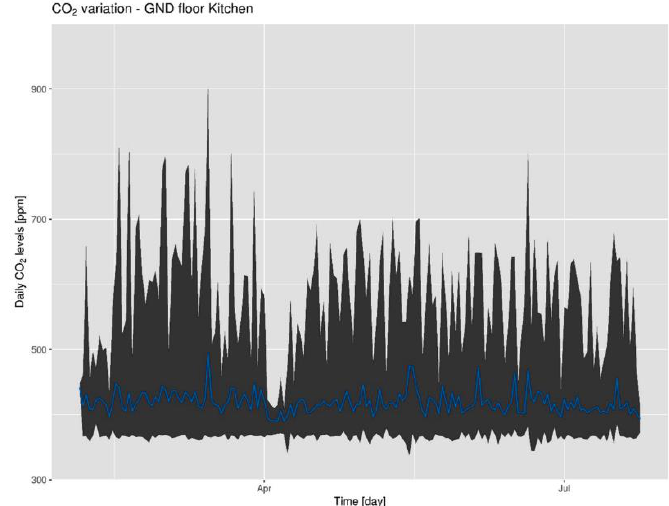
Figure 12. CO 2 variation on ground GND floor kitchen — period February to July 2019.